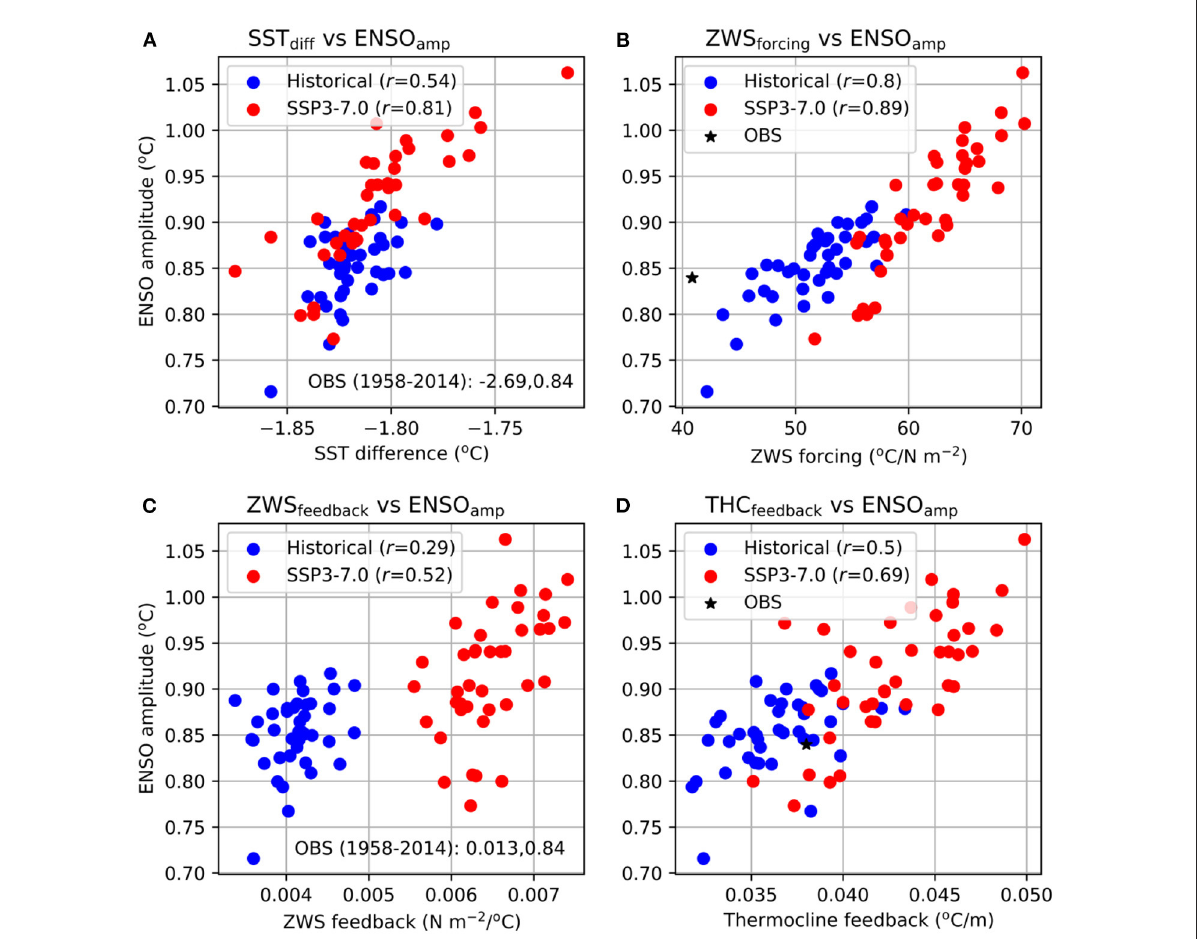
FIGURE4 Relationship between the key ENSO processes and ENSO amplitudes, as calculated from observations and individual simulations of the ACCESS-ESM1.5 historical and SSP3-7.0 large ensembles. ENSO amplitudes vs. (A) differences of mean SSTs between the Niño-3 and Niño-4 regions (as a proxy for the zonal SST gradient), (B) the zonal wind forcings of ENSO-related SST anomalies, (C) the Bjerknes feedbacks, and (D) the thermocline feedbacks. The correlation coefficients for each experiment are shown in the legends. In (A,C) , the observed values are shown as texts (as the values are very large compared to the simulated values, so these cannot be conveniently plotted); in (B,D) , the observed values are plotted as an